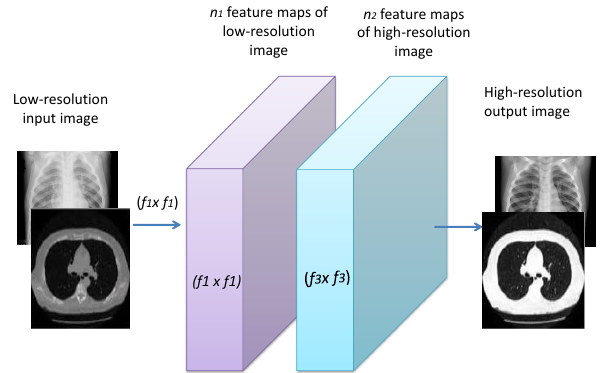
Figure 3. Block diagram of the proposed DCNN image SR